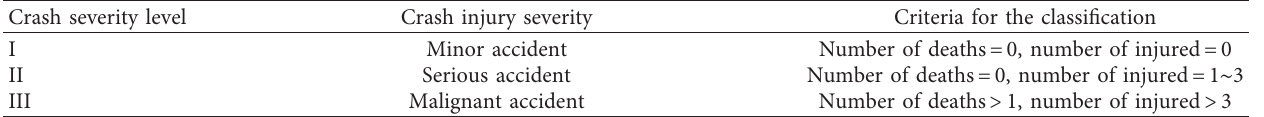
Figure 3: Schematic diagram of typical section division: (a) access segment and (b) village Table 1: Classification of the seriousness of crashes on two-lane rural roads.